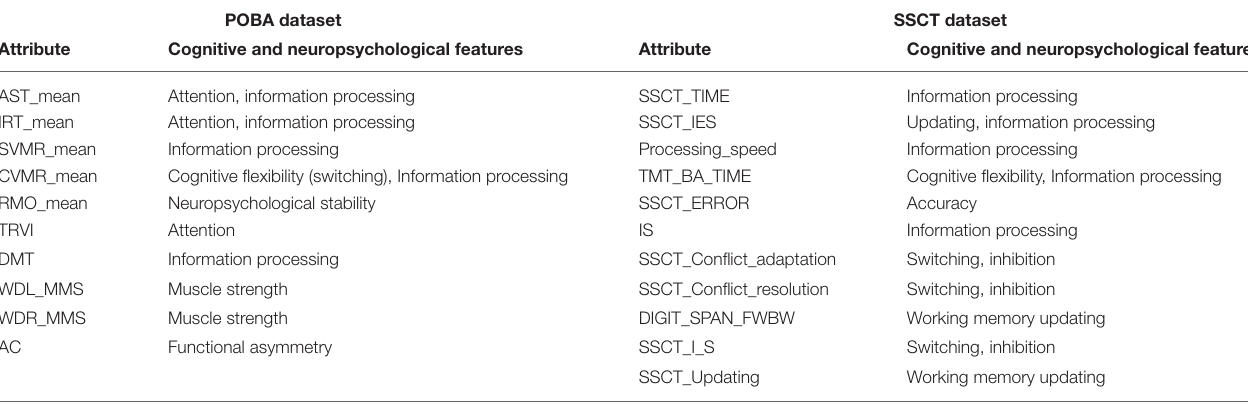
TABLE 7 | Features retrieved using the information gain-based ranker method.